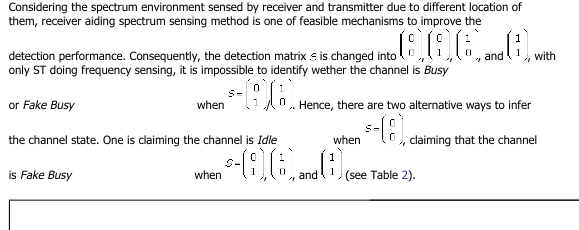
Table 2 Channel state classification according to for transmitter/receiver-cooperated method.